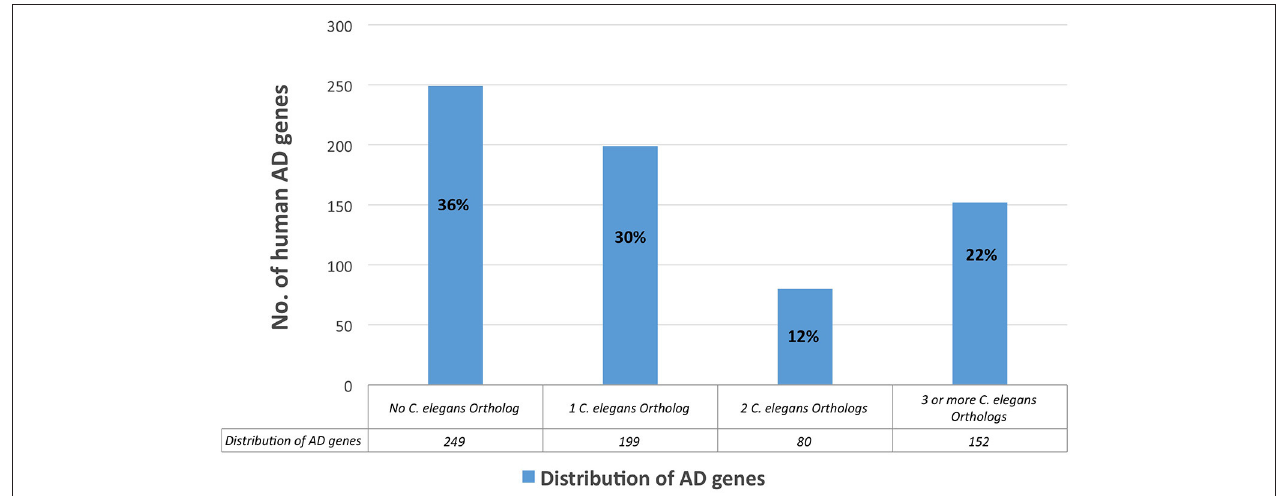
FIGURE 4 | Distribution of the all human AD genes, based on their corresponding number of C. elegans orthologs.